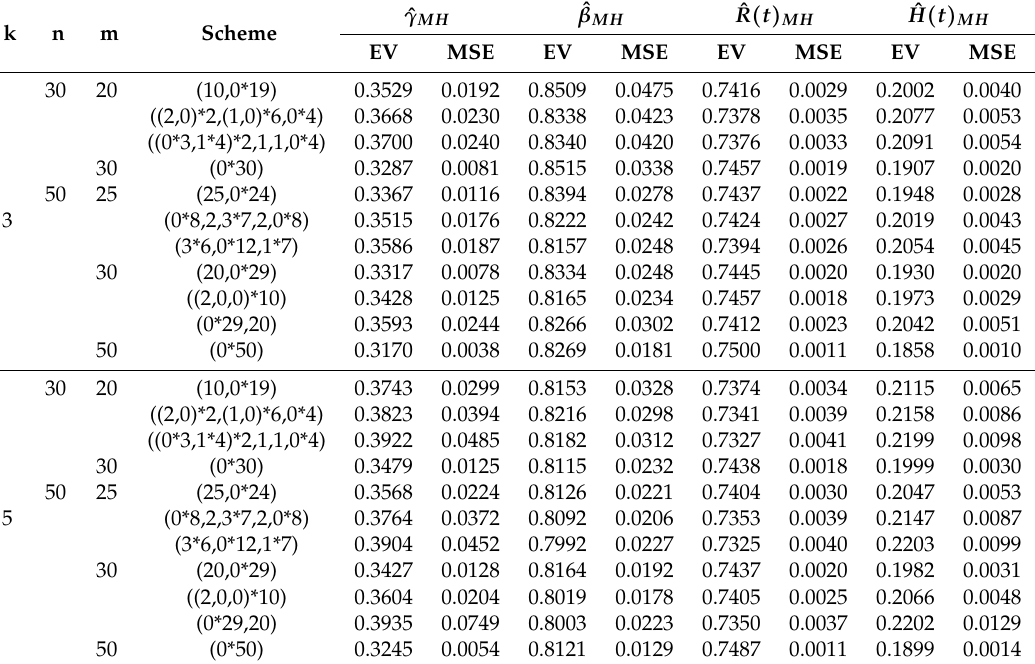
Table 12. Estimation values and MSEs of parameters, reliability and hazard functions using Metropolis-Hastings method under SELF when γ = 0.3, β = 0.8, t = 1.5, a 1 = 1.08, b 1 = 3.6,